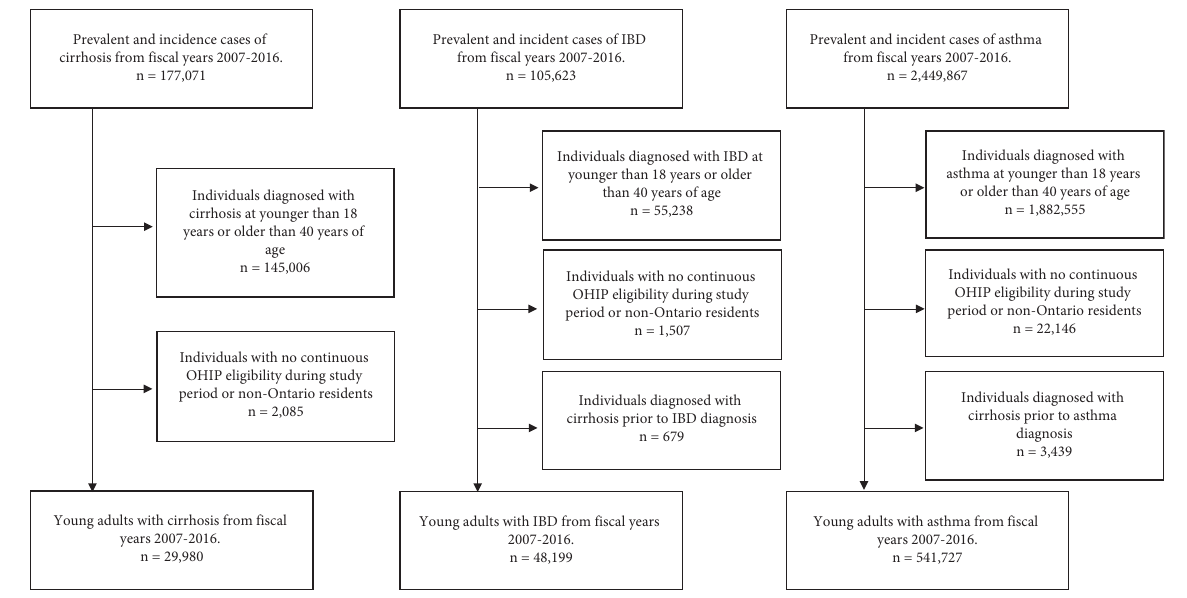
Figure 1: Inclusion and exclusion criteria for the creation of young cirrhosis, IBD, and asthma disease cohorts. Table 1: Demographic and disease characteristics of young adults with cirrhosis, IBD, and asthma in Ontario